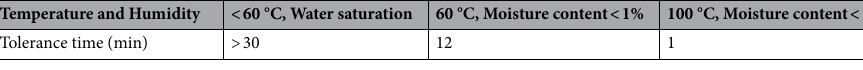
Table 1. Limit of human body tolerance to hot air 25 .